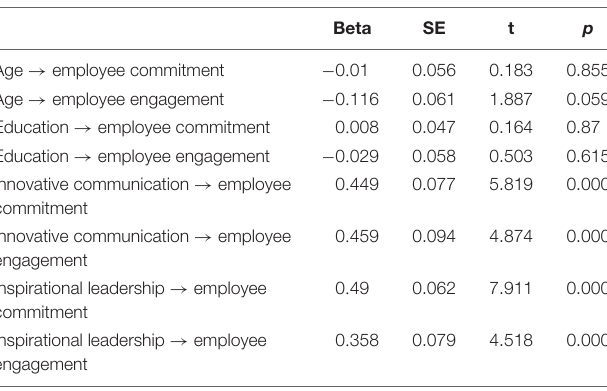
TABLE 4 | Direct effect.